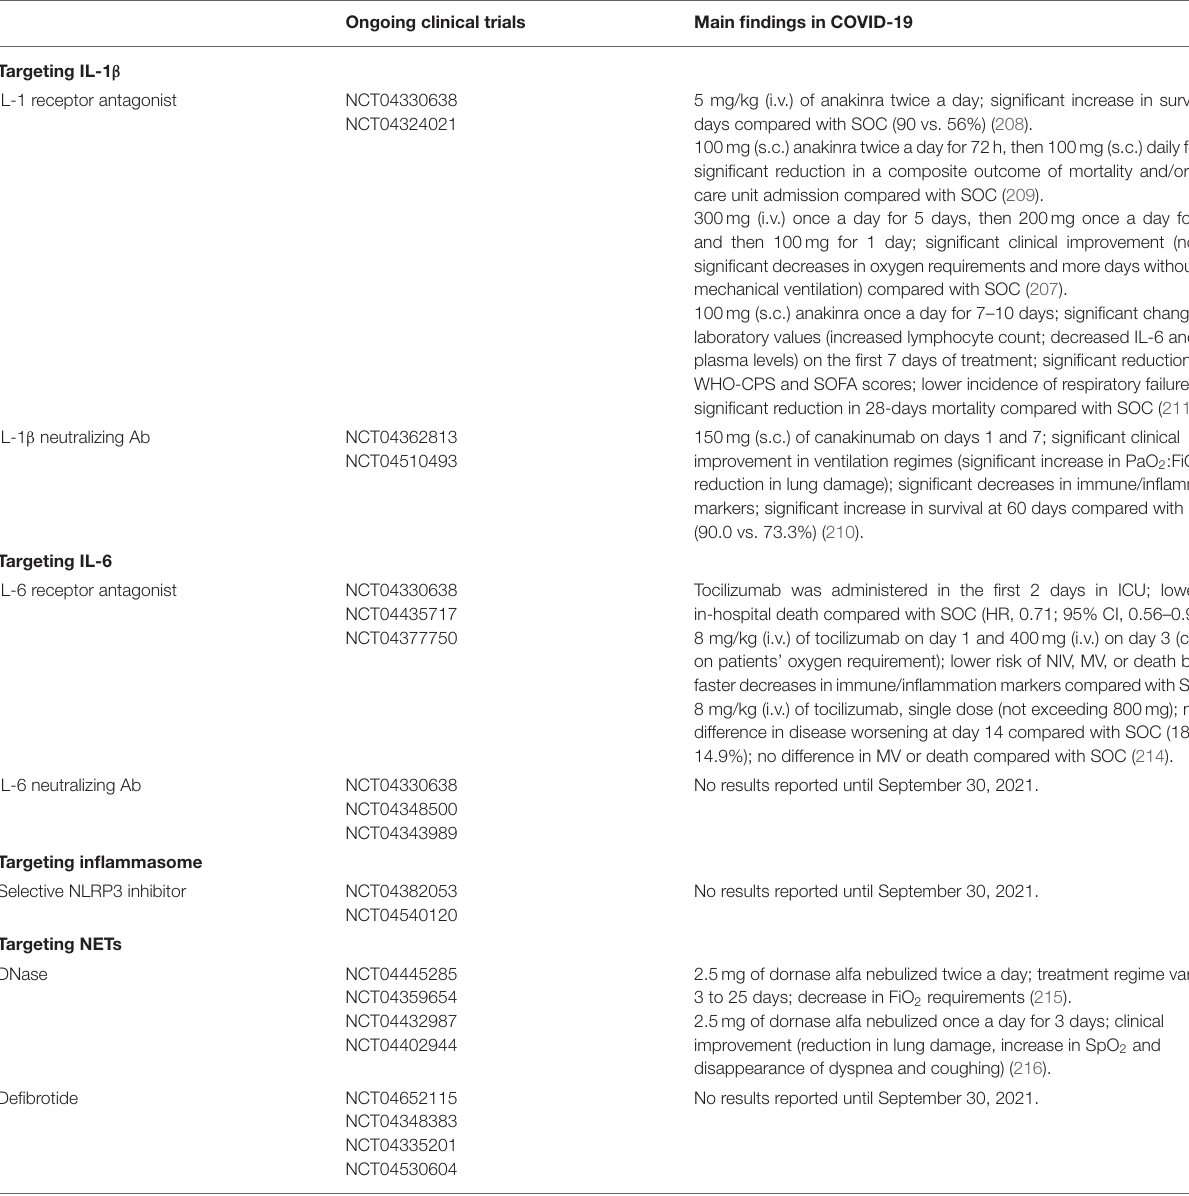
TABLE 1 | Ongoing clinical trials for immunomodulators in